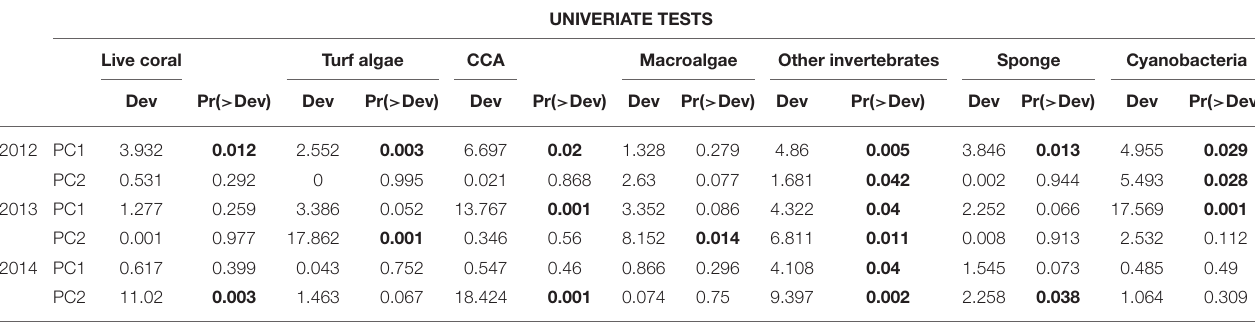
TABLE 5 | Results of univariate GLMs between PC1 and PC2 of environmental water data showing the relationship between water quality and benthic community composition for 2012, 2013, and 2014.